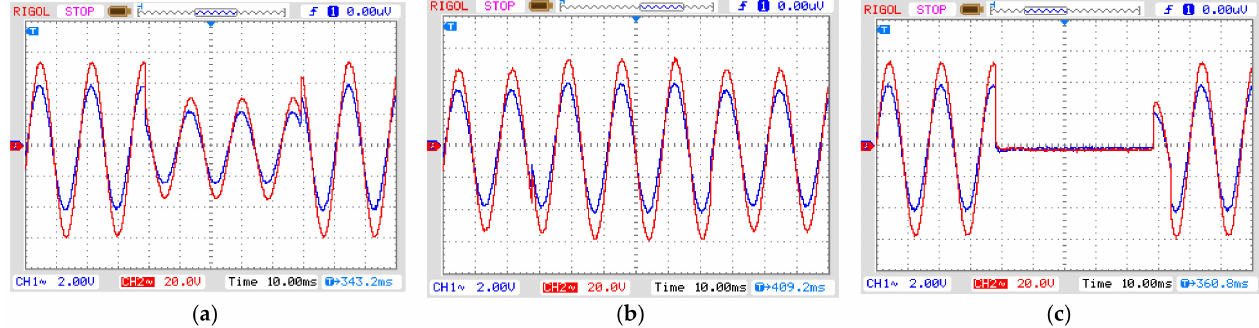
Figure 8. Simulated short-duration voltage as seen from input and output of the amplifier. ( a ) Sag, ( b ) swell and ( c ) inter- ruption. Blue line: input signal from signal generator to amplifier; Red line: output from amplifier (see Figure 5). In all graphs: vertical axis with 2 V/div and horizontal axis with 10